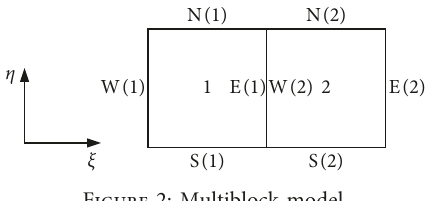
Figure 2: Multiblock model.